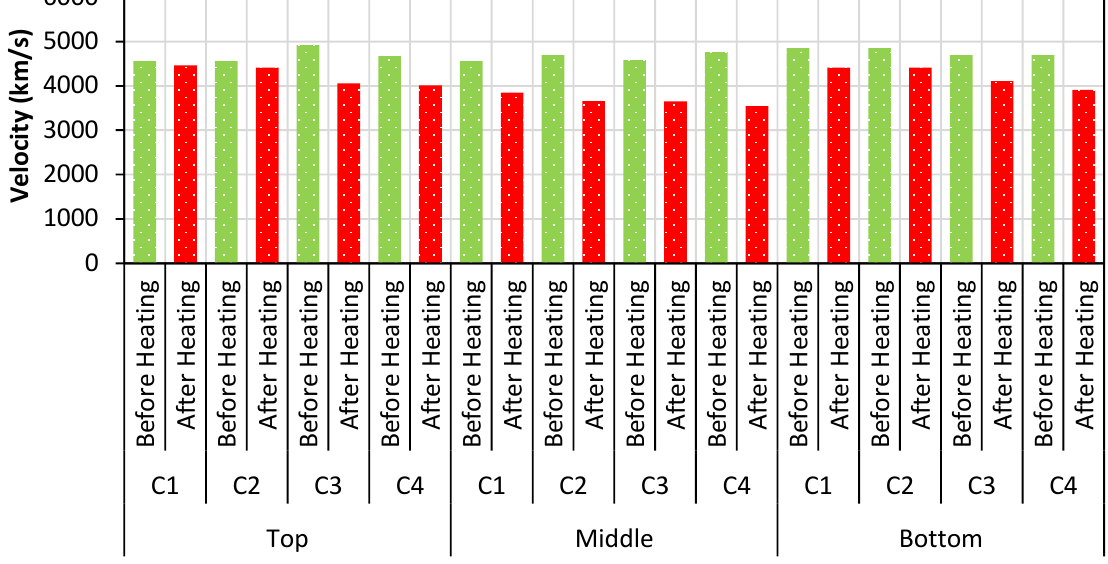
Figure 23. Observed velocity of the specimens at three regions.